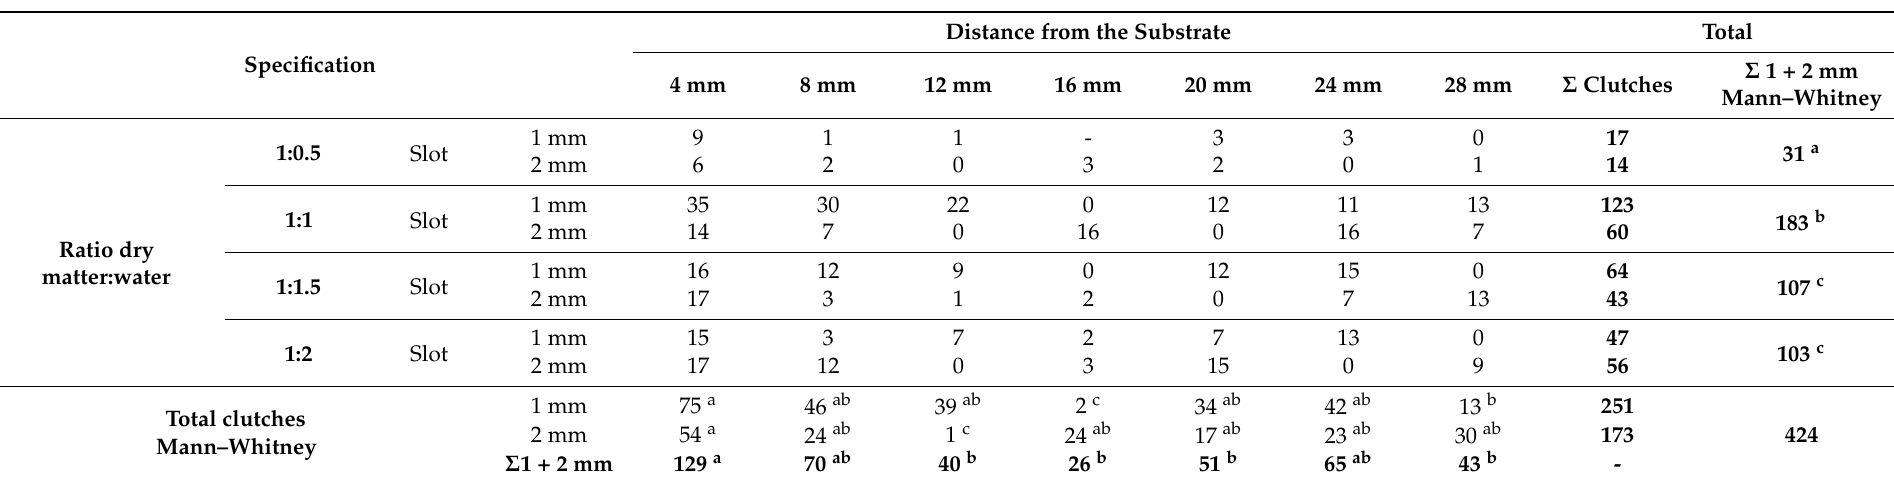
Table 2. Ovipositing rate according to substrate moisture, slot size (1 mm and 2 mm) and distance to the